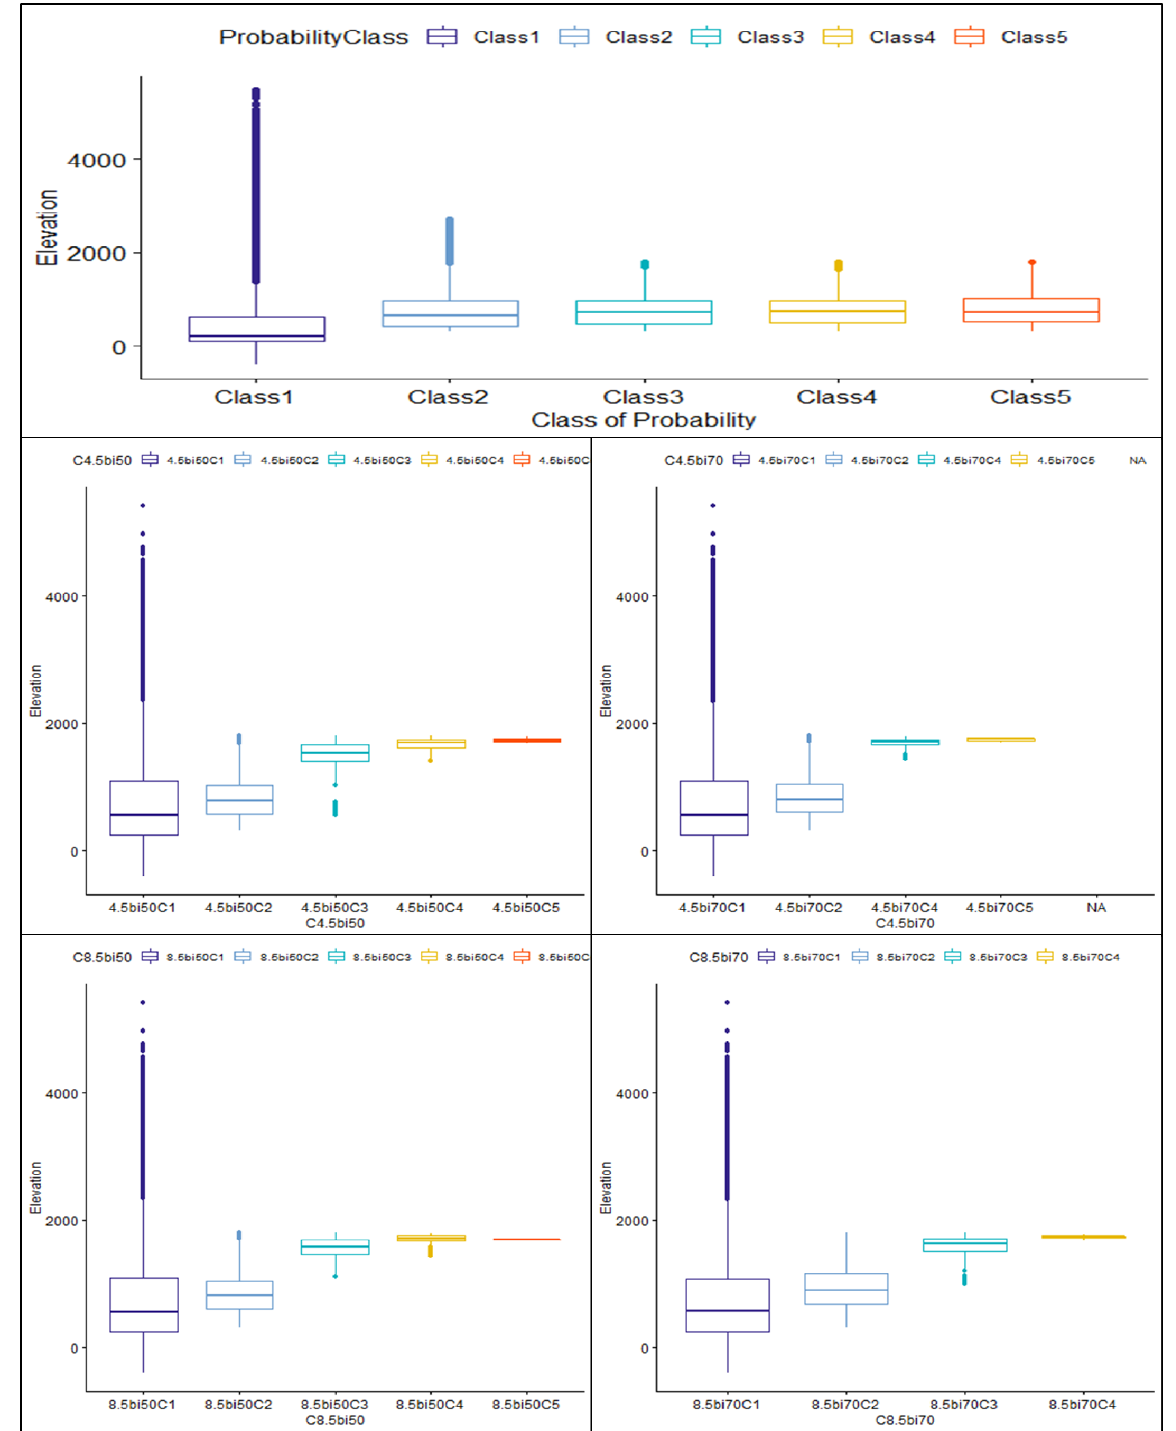
Figure 10. Changes in the altitude range of modeled actual and future distribution by class of suitability. C represents classes of suitability; 4.5 and 8.5 represent RCP 4.5 and RCP 8.5, respectively; bi 50 represents the bioclimatic condition of the period 2040–2060; bi 70 represents the bioclimatic condition of the period 2060–2080; and C1, C2, C3, C4, C5 represent class 1, class 2, class 3, class 4, class 5 of suitability.